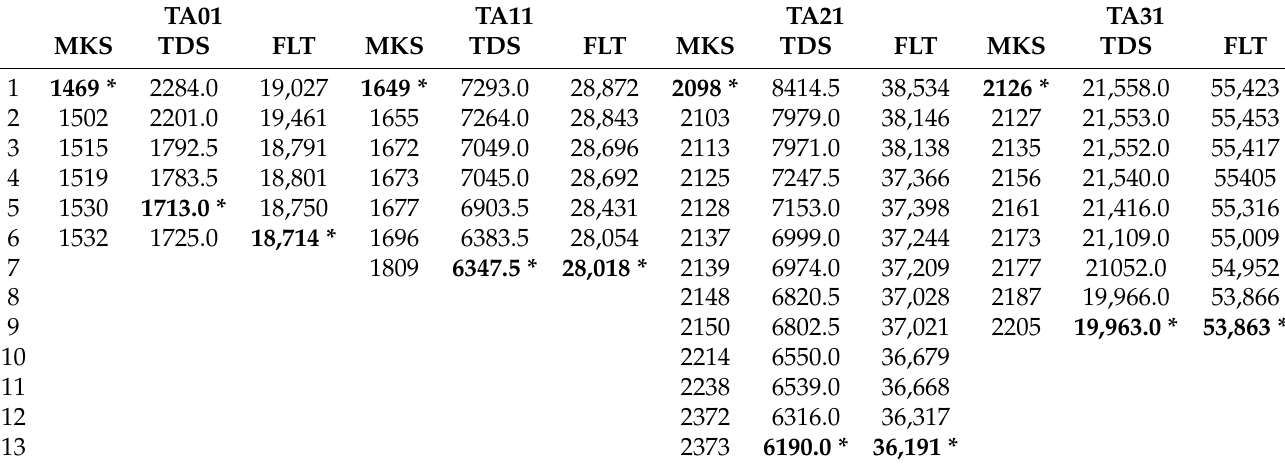
Table A12. Non-dominated front obtained by CMOTA for the JSSP instances proposed by